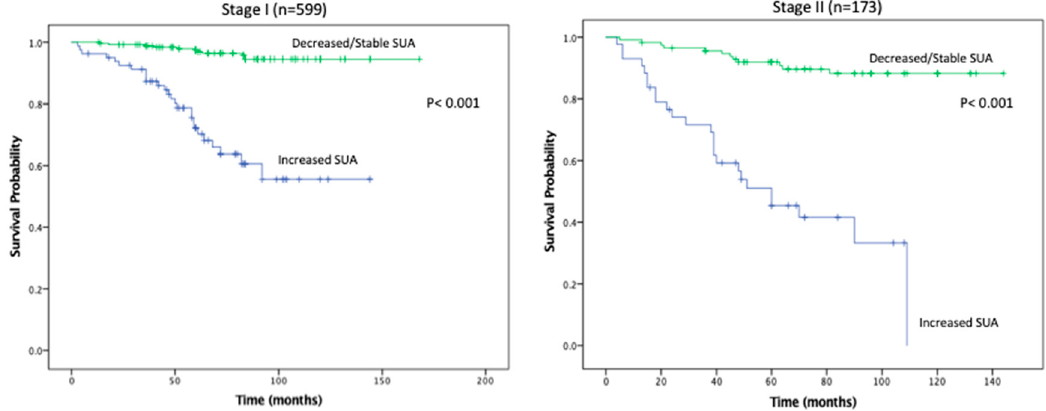
Figure 4. Cont Figure 4. Cont. Figure 4. Cont.